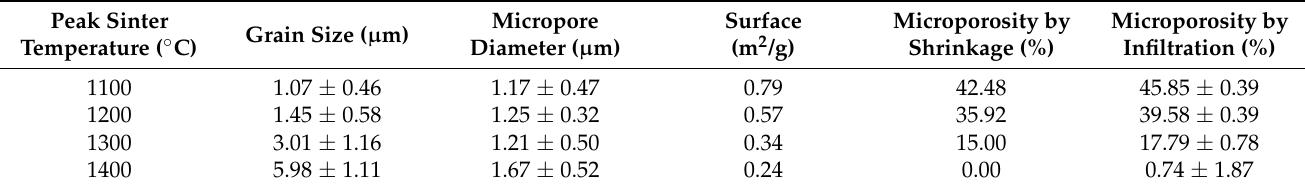
Table 1. Characteristics of the sintering temperature dependent